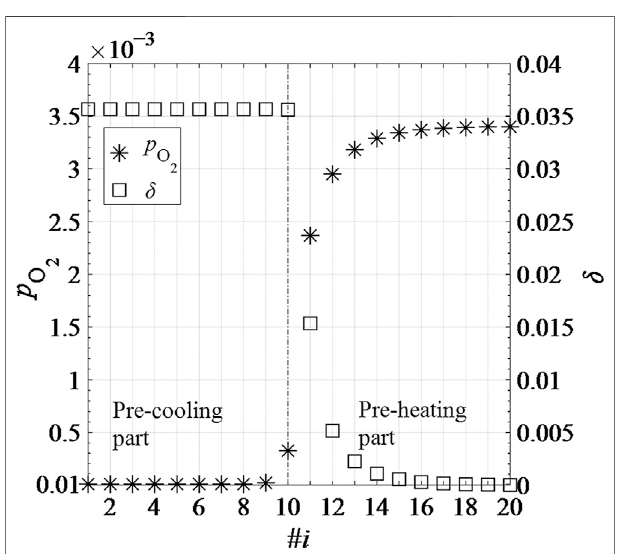
FIGURE 11 | Thermodynamic parameters δ and p O recuperation CRR position (# i ) at the end of a cycle under steady conditions.